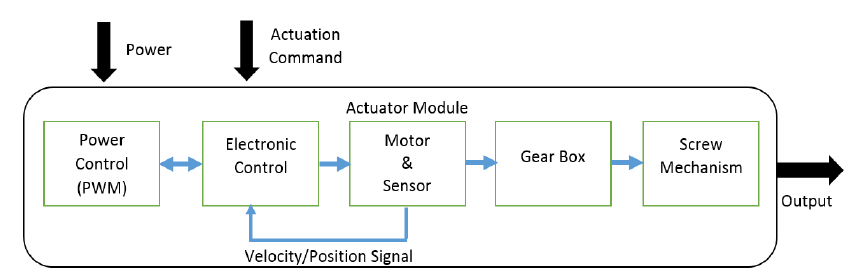
Figure 1. Electro-mechanical Actuator (EMA) schematic. This figure identifies the components of an electro-mechanical